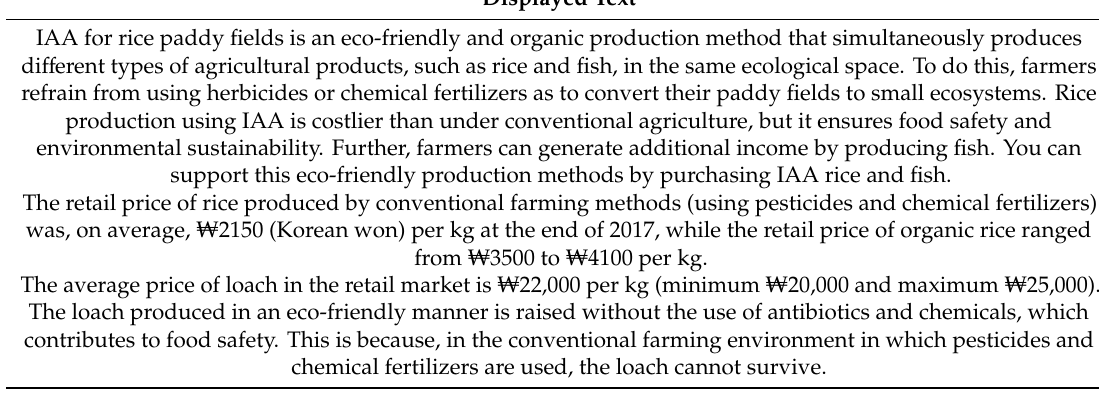
Table 1. Description of sustainable integrated agriculture–aquaculture (IAA) and price information in the survey questionnaire.